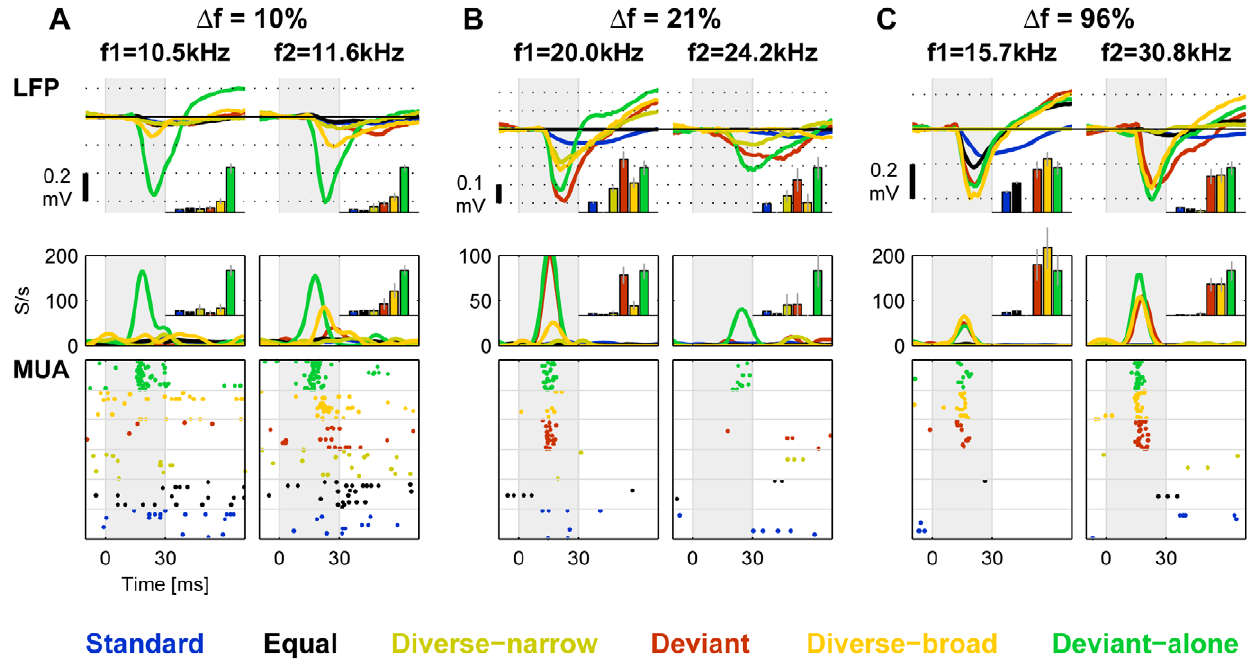
Figure 6. Responses as a function of D f. A. LFP and the corresponding MUA responses to the two frequencies in a paradigm with D f=10%. B. D f=21% (from another animal). C. D f=96% (another animal). Same conventions as in Fig. 4.